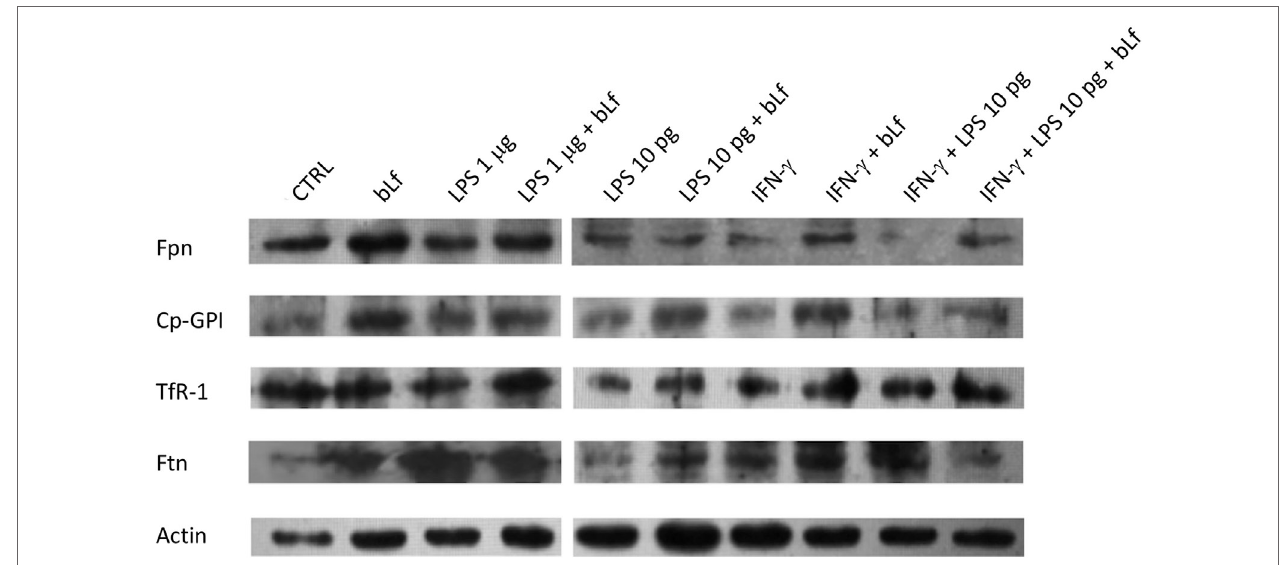
FigUre 5 | Representative Western Blot assays on ferroportin (Fpn), membrane-bound ceruloplasmin (Cp), transferrin receptor 1, and cytosolic ferritin (Ftn) in THP-1 cells stimulated both with a mixture of 20 ng/ml IFN- γ and 10 pg/ml LPS or with LPS 1 µg/ml, in the presence or absence of 100 µg/ml bovine Lf